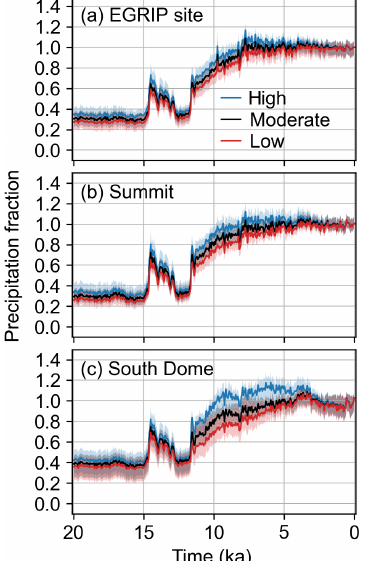
Figure 10. Ensemble mean and 5th to 95th percentile shading for the main precipitation reanalysis (black), high-sensitivity scenario (blue), and low-sensitivity scenario (red). Fractions are with respect to the mean of 1850–2000 CE. Panel (a) is the time series for the location closest to the EGRIP ice-core site, panel (b) is closest to Summit, and panel (c) is closest to South Dome, which are represen- tative of northern, central, and southern Greenland and are shown on a map in Fig.